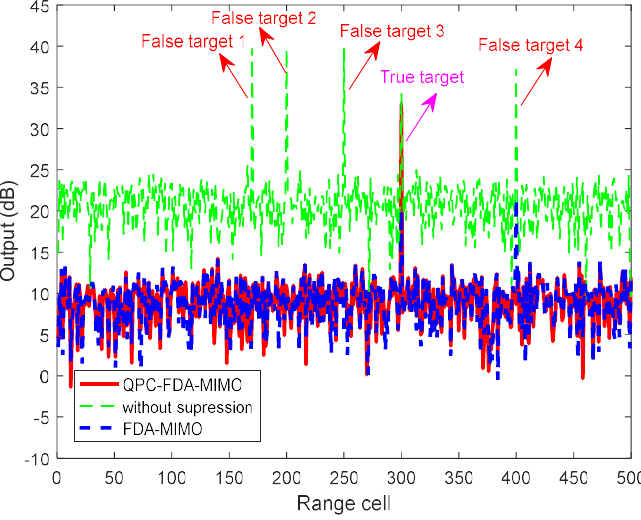
Figure 8. Comparison of output results.